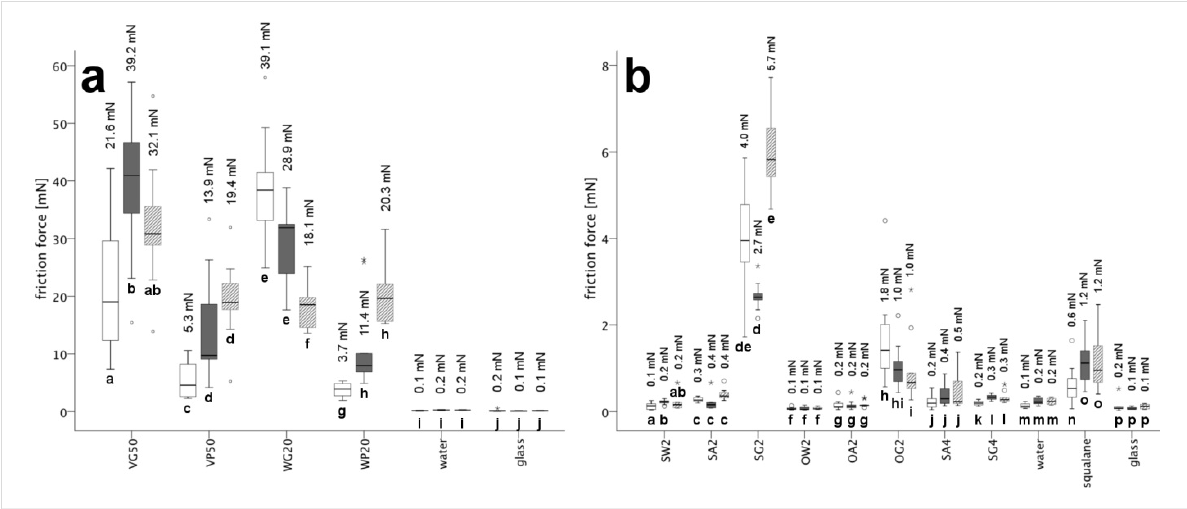
Figure 4: Box-plots of the friction forces of the emulsions of both emulsion generations at speeds of 50 (white), 200 (dark grey) and 500 (grey striped) µm s − 1 . The asterisk and circles above and below the boxes categorize outliers (asterisk) and extreme values (circle). Outliers are defined as values showing a distance of 1.5–3 times the box height from the box border (25% and 75% quantile), whereas the distance of extreme values is larger than 3 times of the box height. Significant differences between the three different velocities within an emulsion of logarithmized values (Supporting Informa- tion File 1, Tables S11 and S12) are indicated by different small letters (Friedman test followed by Friedman post hoc multiple comparisons). The statistical comparison of the friction within each emulsion refers to common logarithmized friction forces. The measured values refer to a surface area of the silicium wafer of 6.45 mm 2 and a normal load of 0.6 mN. The value above each box depicts the arithmetic mean of its friction measurements as reported in Supporting Information File 1, Table S2. (a) Friction forces of the first generation (Supporting Information File 1, Table S2). The